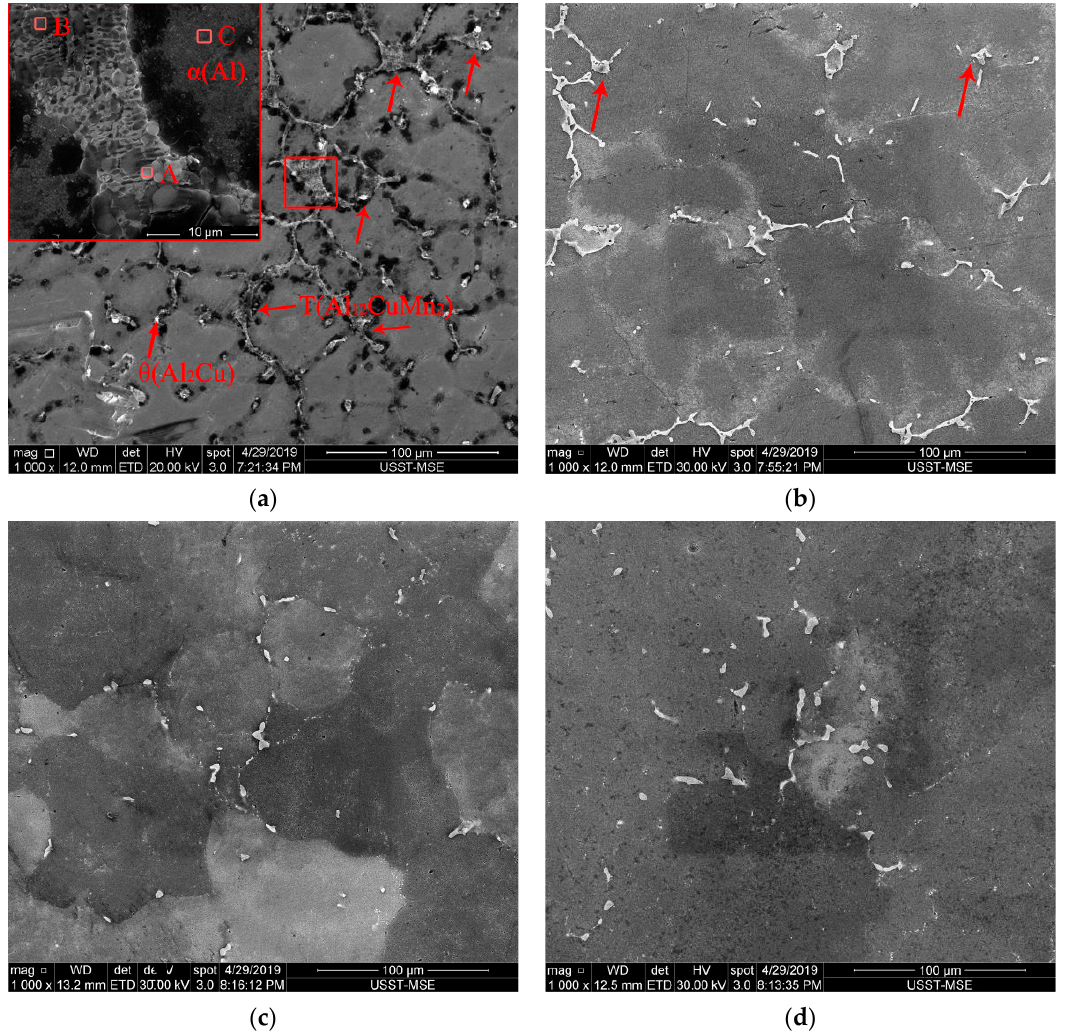
Figure 4. Scanning electron microscopy micrographs of squeeze-cast ZL205A: ( a ) as-cast; ( b – d ) after solution treatment at 538 °C, ( b ) 6 h; ( c ) 15 h; ( d ) 17 h.